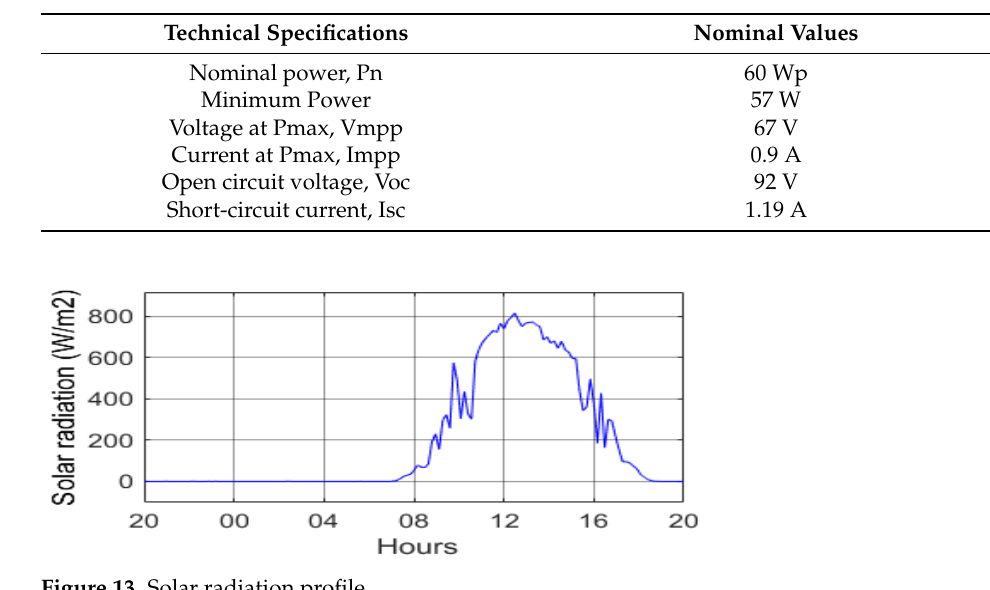
Figure 13. Solar radiation profile.